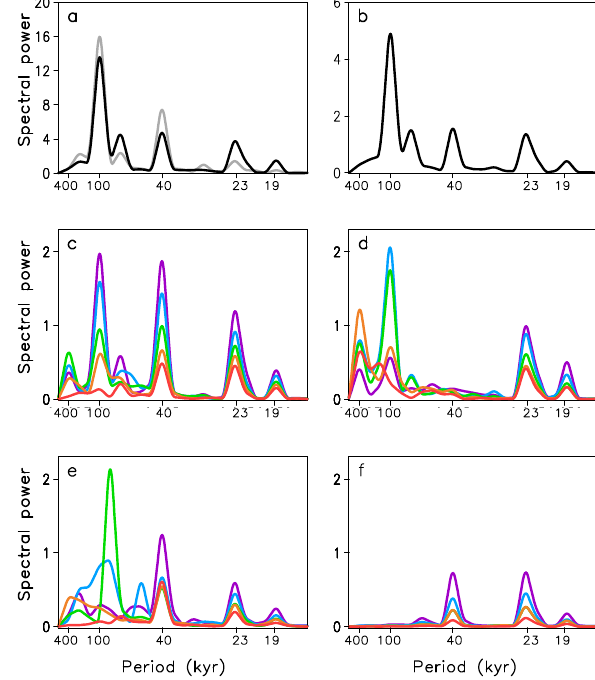
Fig. 3. (a) Frequency spectrum of the simulated (black) versus re- constructed (grey) benthic δ 18 O c stack (Lisiecki and Raymo, 2005); (b) – (f) frequency spectra of the simulated ice volume: (b) Baseline experiment, (c) CC n experiments with constant CO 2 , (d) COB n ex- periments with constant obliquity, (e) CEC n/ 0.02 experiments with constant (0.02) eccentricity, (f) REG n experiments with continents completely covered by sediments. In (c) – (f) , purple lines corre- spond to a CO 2 concentration of 200ppm, blue – 220ppm, green – 240ppm, orange – 260ppm and red –